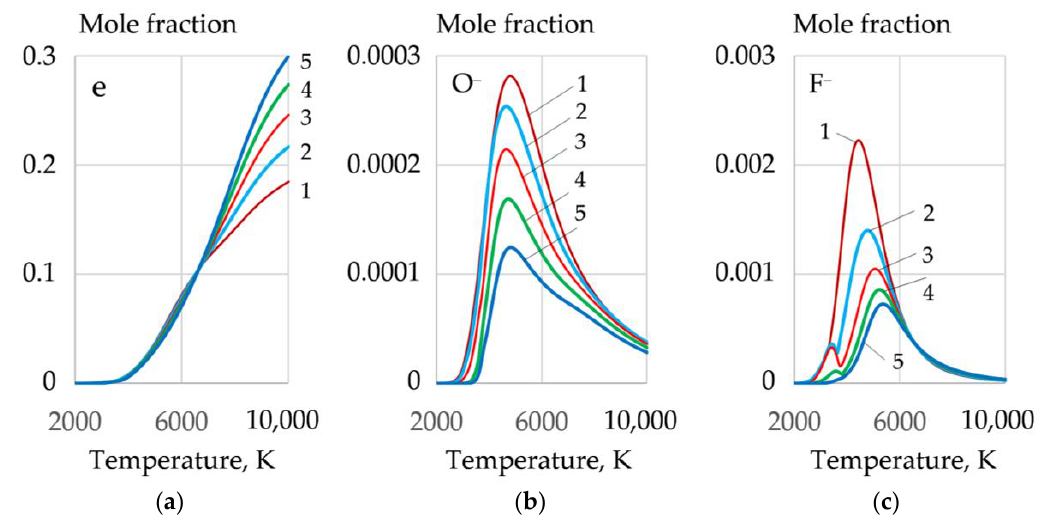
Figure 10. Mole fractions of electrons ( a ), negative ions of atomic oxygen ( b ), and negative ions of fluorine ( c ) in the equilibrium gas system, wt.%: ( 1 ) 40FeCO 3 + 40KNO 3 + 20Na 3 AlF 6 ; ( 2 ) 35FeCO 3 + 35KNO 3 + 20Na 3 AlF 6 + 10Al; ( 3 ) 30FeCO 3 + 30KNO 3 + 20Na 3 AlF 6 + 20Al; ( 4 ) 25FeCO 3 + 25KNO 3 + 20Na 3 AlF 6 + 30Al; ( 5 ) 20FeCO 3 + 20KNO 3 + 20Na 3 AlF 6 + 40Al.